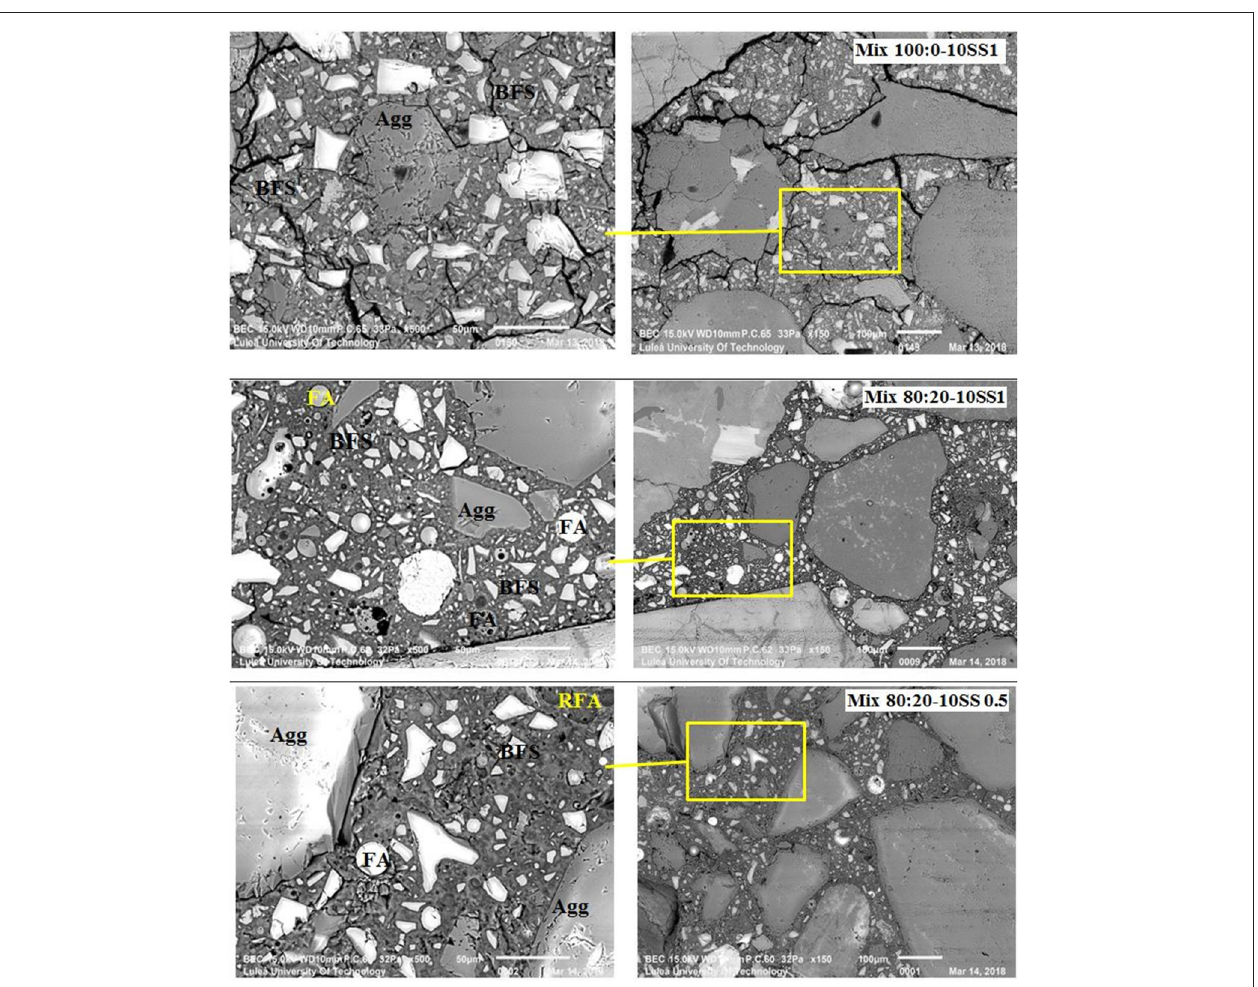
Frontiers in Materials |